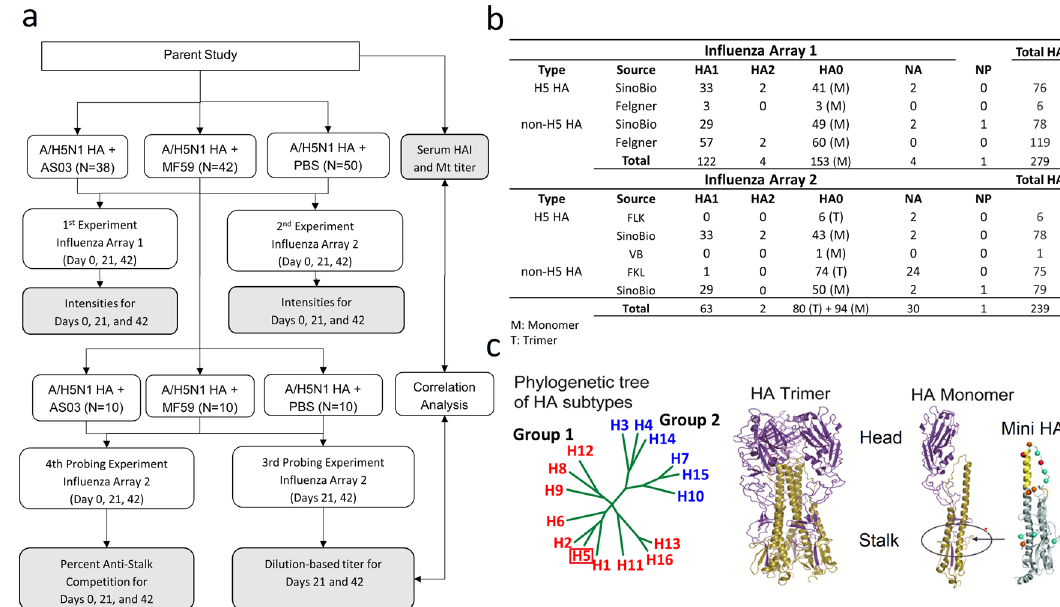
Fig. 1 Study overview. a Study design. b Protein array antigen composition. c HA Subtype relationship 51 , H5 trimer structure, Mini-HA binding used for assessing percent anti-stalk competition 49